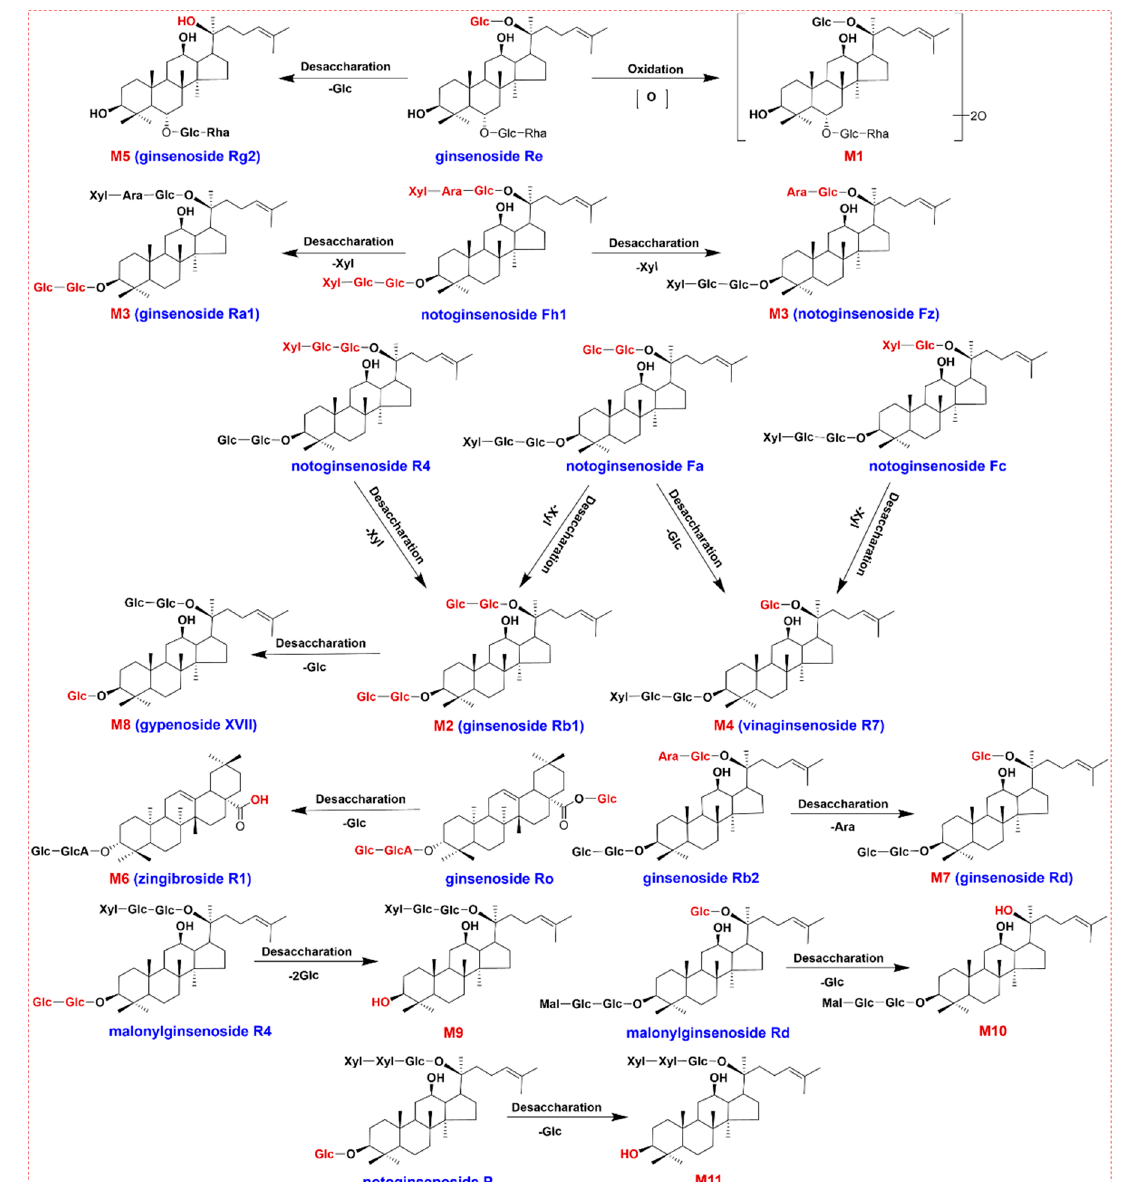
Figure 6. Proposed metabolic pathways for the ginsenosides of PNF.